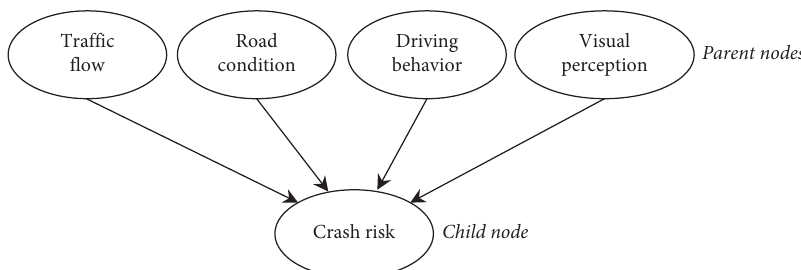
Figure 10: An example of the BN